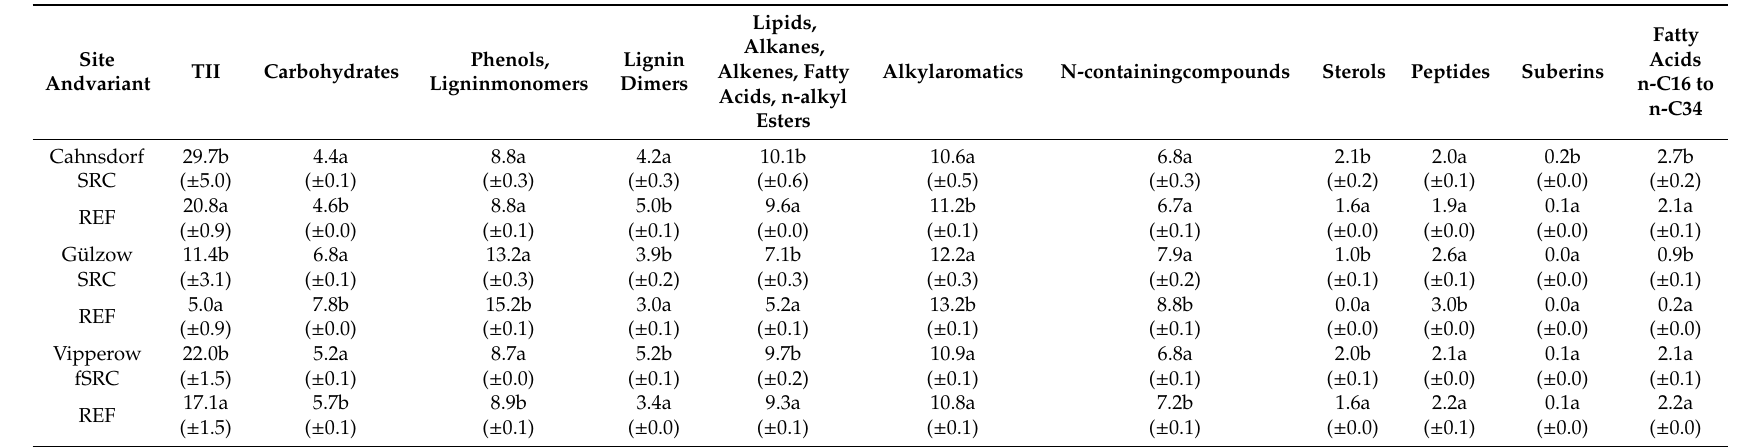
Table 4. Total ion intensity (TII) and relative abundance of 10 compound classes of soil organic matter under short rotation coppice (SRC), former SRC (fSRC) and reference sites with cereals or grass (REF) at three test sites (Cahnsdorf, Gülzow, Vipperow) in Germany (means of 3 replicates, ± SD given in